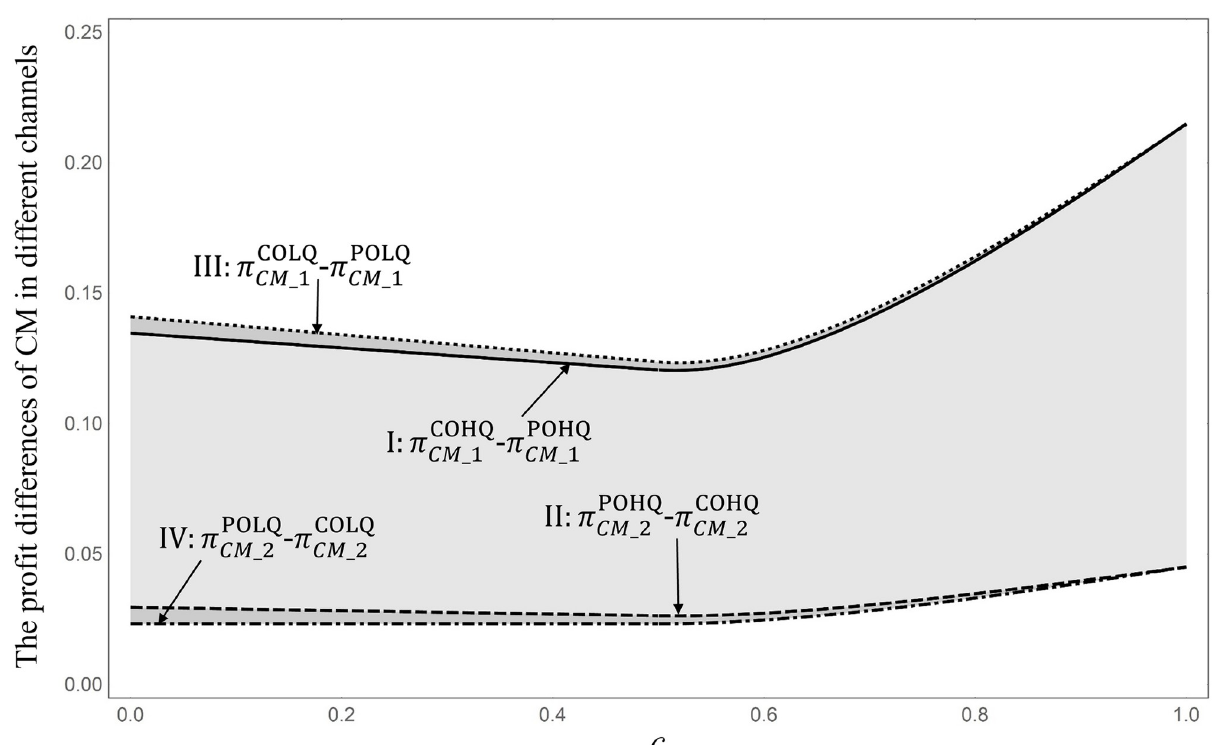
Fig 6. Impact of the M 1 strategy choice on profit of the CM in different channels ( a = 1; α = 0.742; m = 0.266; q L = 0.017).